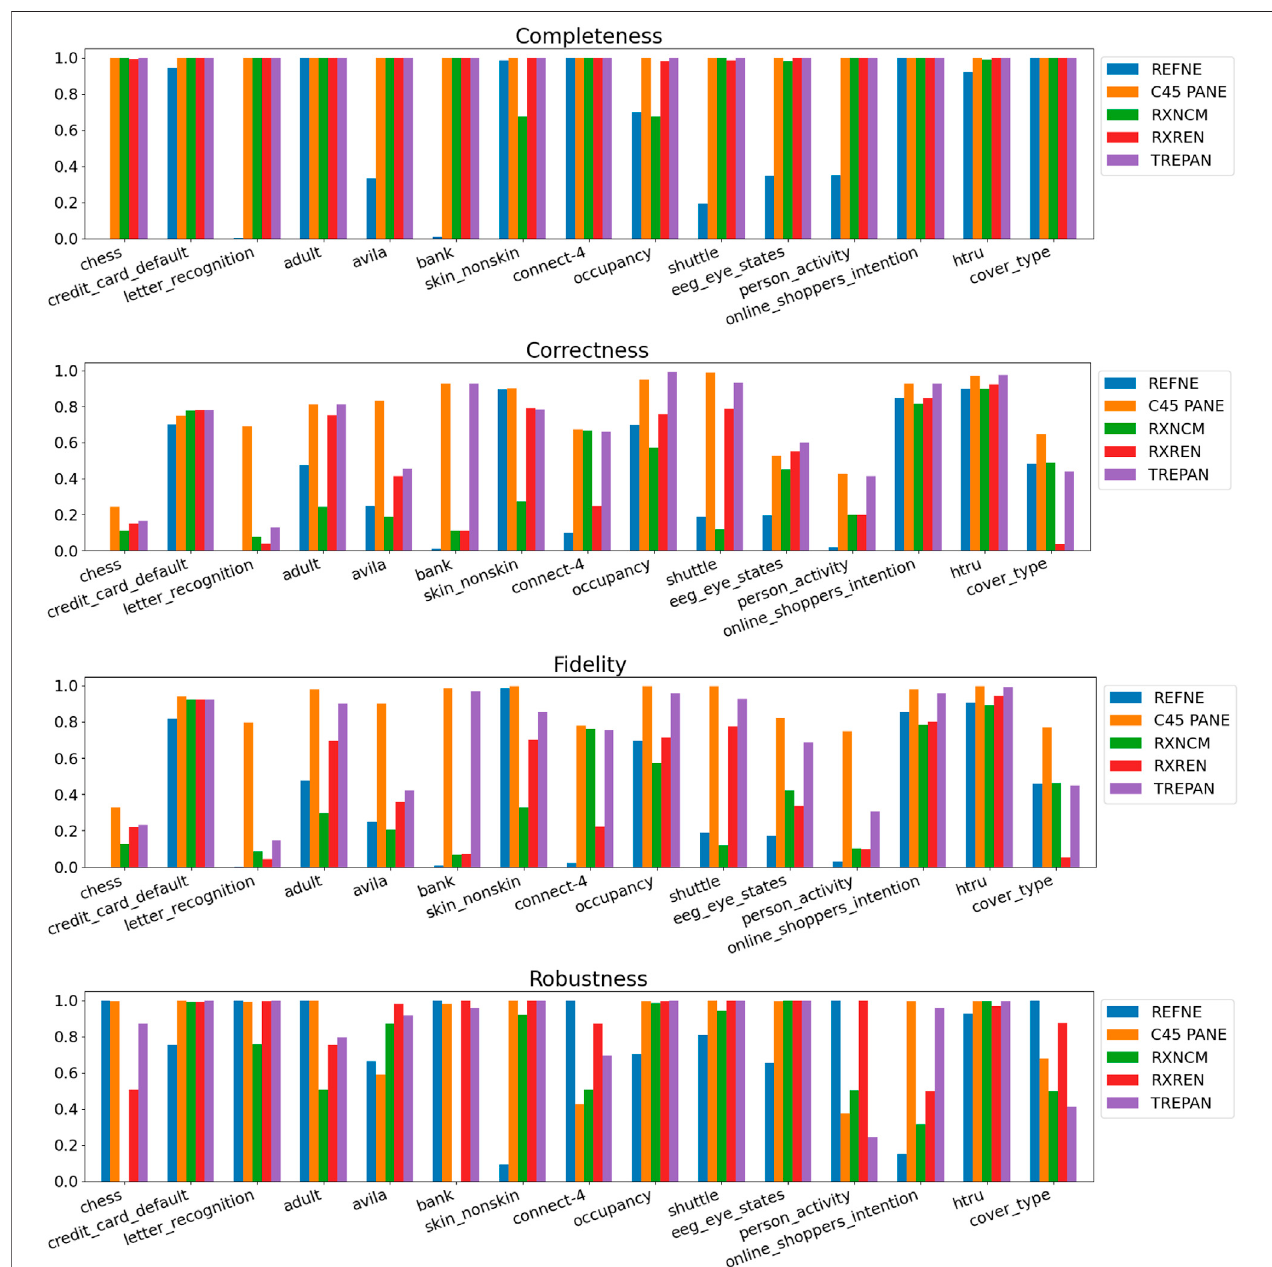
FIGURE7| Quantitativemeasuresofthedegreeofexplainabilityoftherulesetsautomaticallygeneratedby5rule-extractionmethodsover15datasets,groupedby dataset.